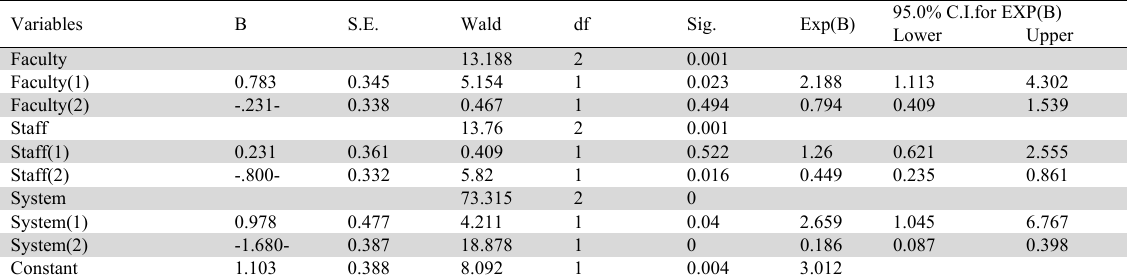
Results of Logistic Regression